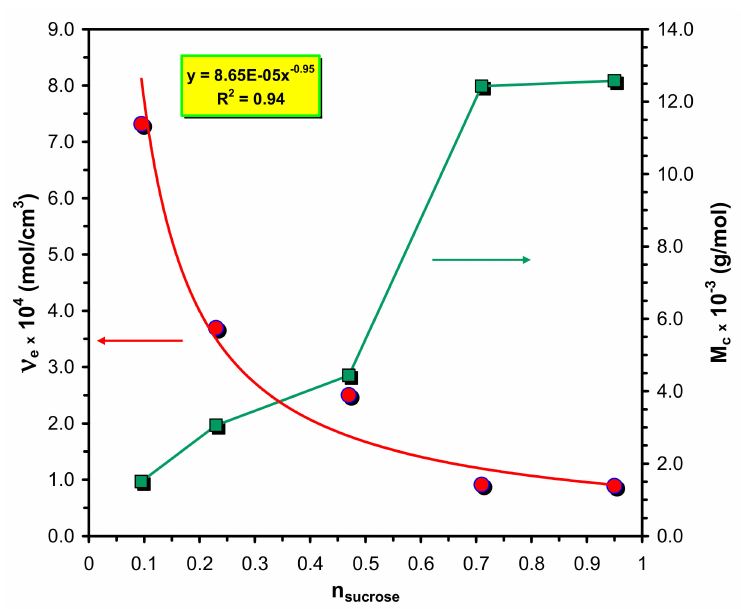
Figure 5. Dependence of the crosslink densities ( ν e ) and the average molecular weights of the segment between crosslinks ( M c ) on the sucrose